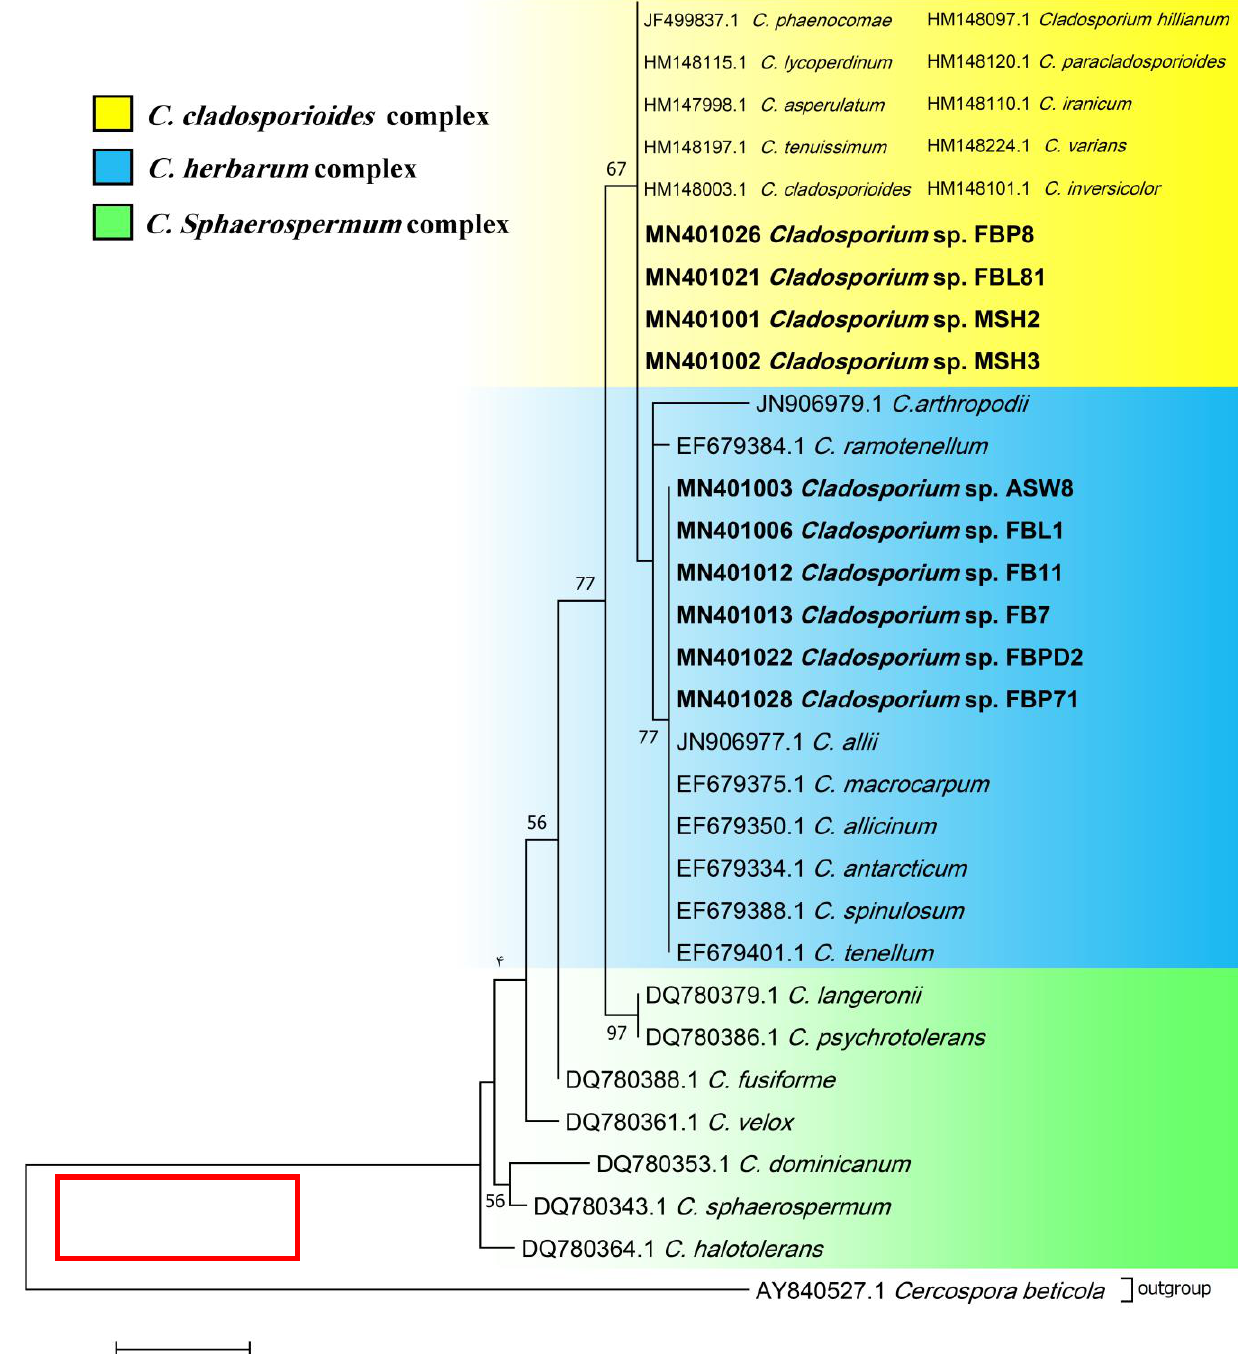
Figure 3. ITS phylogenetic trees of the genus Cladosporium and related genera. The analyses were performed based on the alignments of ITS1-5.8S-ITS2 (453 bp) using the maximum likelihood method from isolates in this study (bold) and validly published sequences from GenBank. The numbers next to the branches show bootstraps values ≥ 50%. Cercospora beticola was considered an